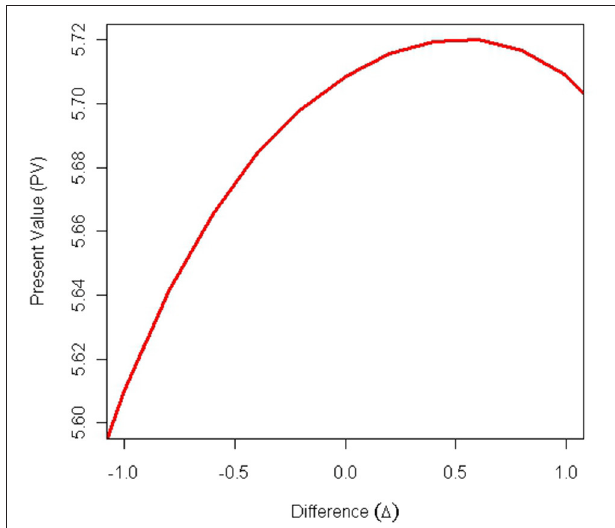
FIGURE 1 | Present value as a function of the common difference 1 (Example